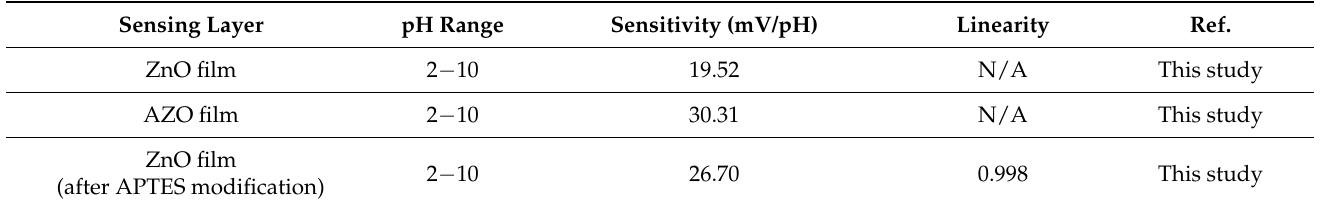
Figure 6. The average sensitivity and linearity of the pH sensors based on ( a ) ZnO and ( b ) AZO films after APTES modification. Table 4. Comparisons of the average sensitivity and linearity based on pH sensors with different sensing materials.